Question: Describe this figure in one sentence.
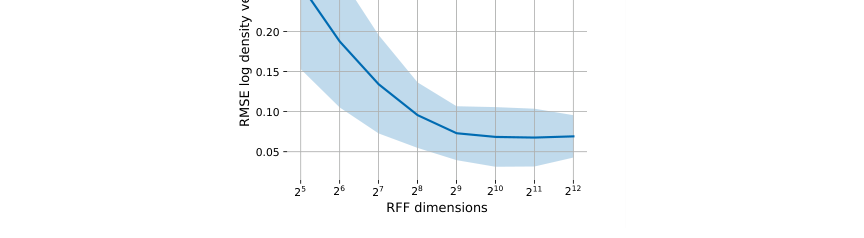
Answer: shows how the accuracy of DMKDE increases with an increasing number of RFF. For each configuration 30 experiments were run and the blue solid line represents the mean RMSE of the experiments and the blue region represents the 95% confidence interval. In all the three datasets, 210 RFF